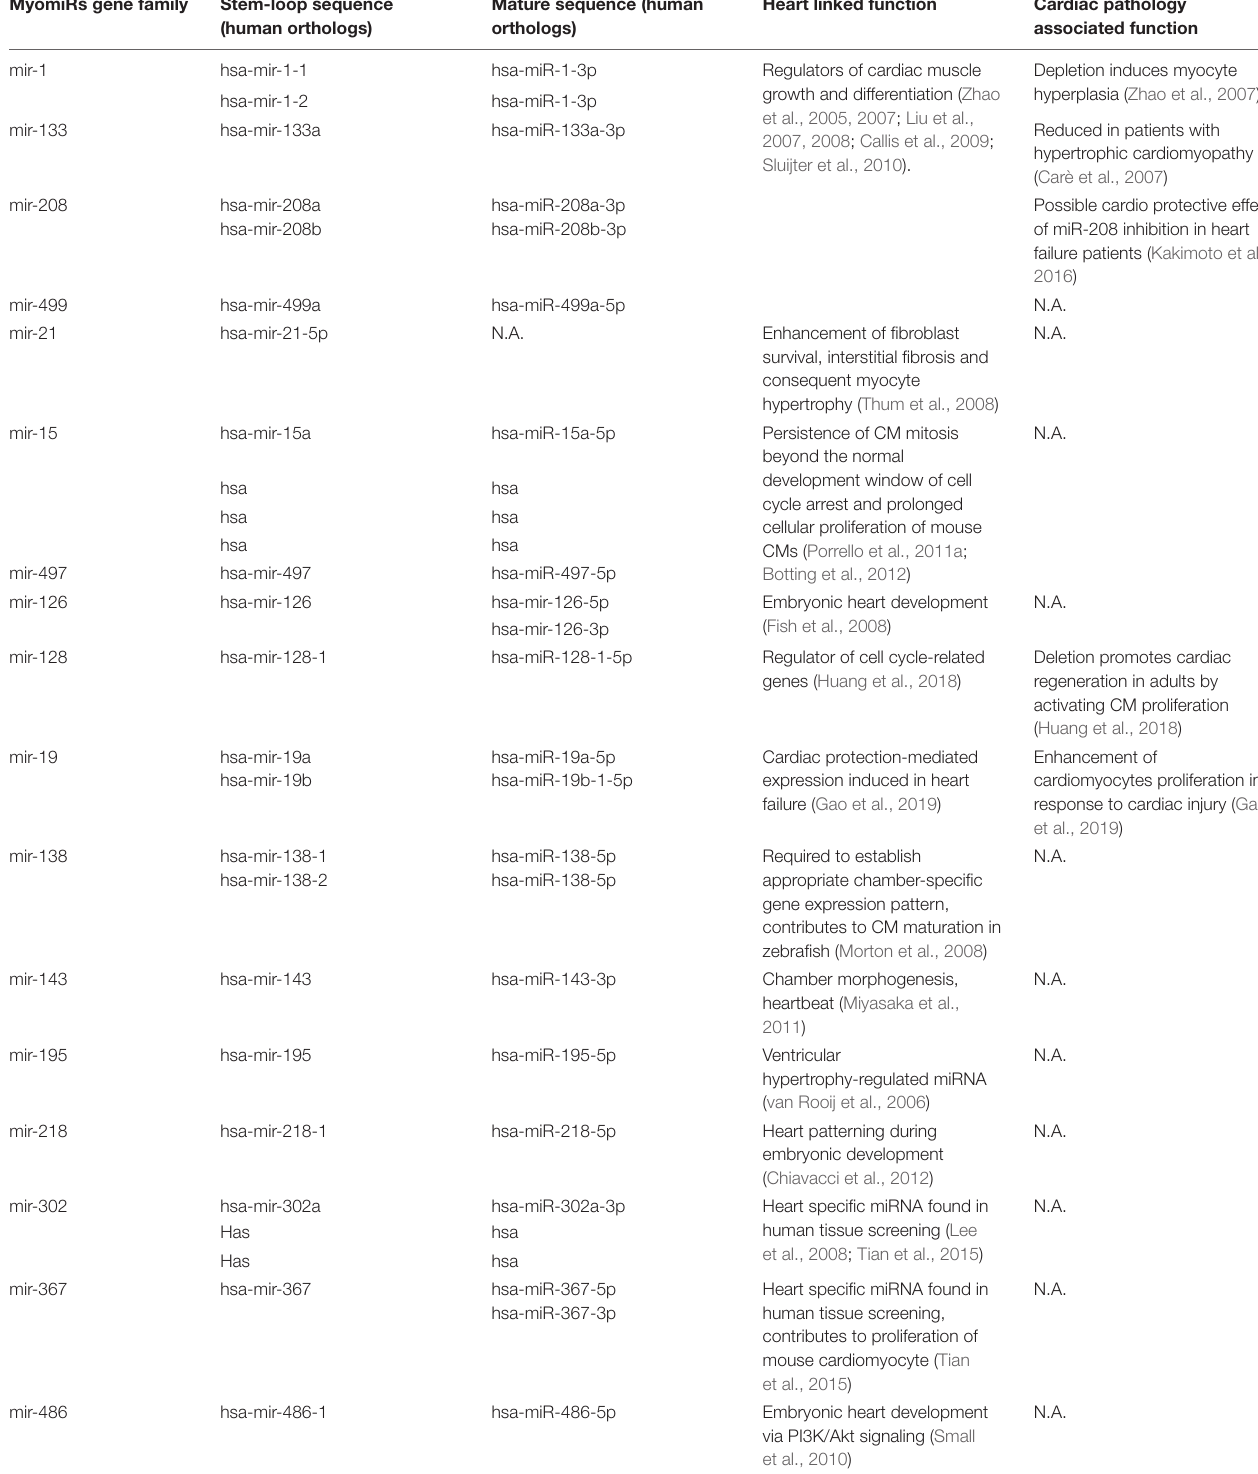
TABLE 1 | Cardiac function associated miRNAs with references to heart human orthologs. MyomiRs gene